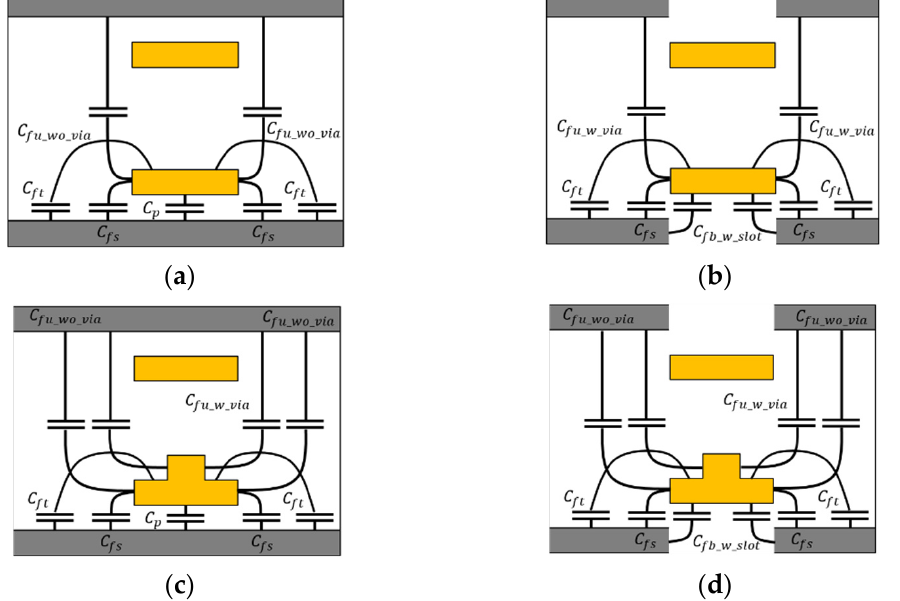
Figure 3. Cross-section view of self-capacitance of the proposed channel structure. ( a ) section 1: without the vertical tabbed via and without the ground slot, ( b ) section 2: without the vertical tabbed via and with the ground slot, ( c ) section 3: with the vertical tabbed via and without the ground slot, ( d ) section 4: with the vertical tabbed via and with the ground